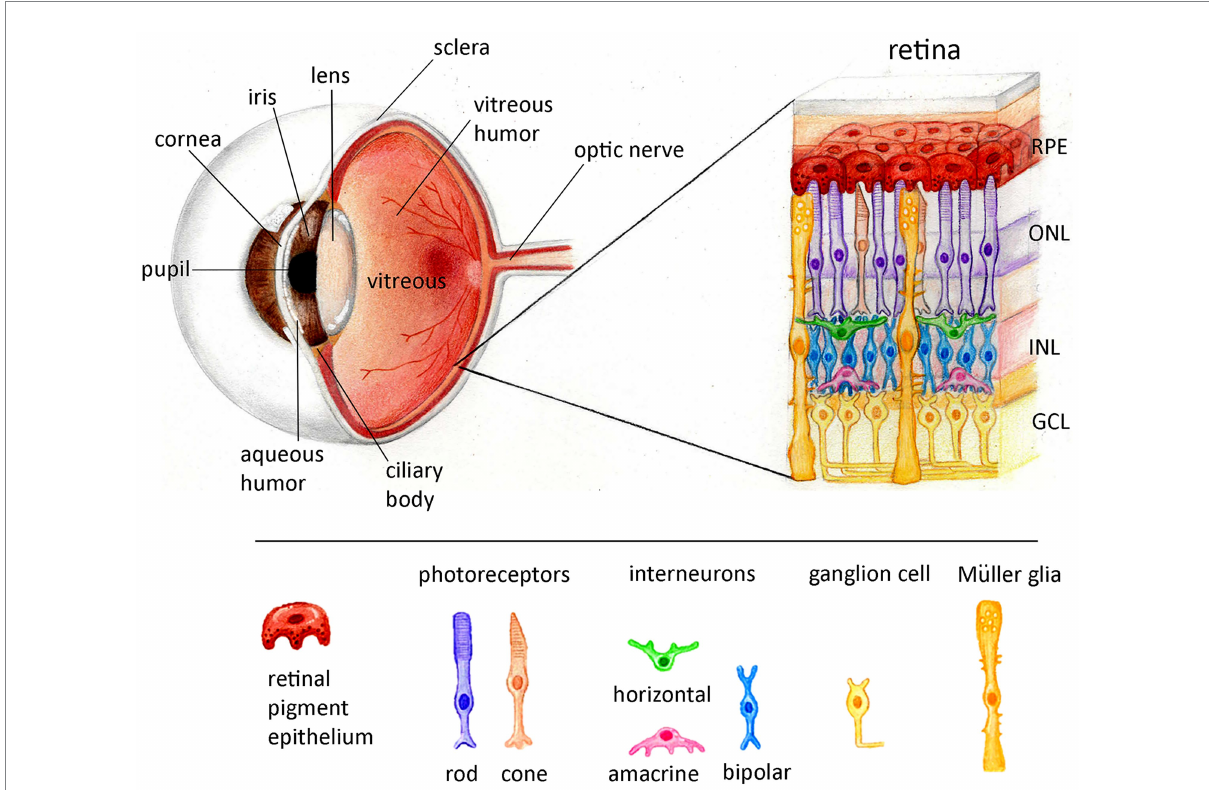
FIGURE 1 Schematic representation of the anatomical features of the eye and the lamination of the retina. The eye is anatomically divided in three layers. The external layer of the eye consists of the cornea, and sclera. The intermediate layer includes-at the anterior-the iris and ciliary body and in the posterior the choroid (not shown here). The internal layer is comprised by the retina. The space is filled with fluid called the aqueous humor, at the anterior chamber, or vitreous humor between the lens and the retina. The retina is divided in two compartments: one non-neuronal, the retina pigment epithelium (RPE) and one neuronal, the neuroretina. The vertebrate neuroretina is laminated in three layers of nerve cell bodies and two layers of synapses. The outer nuclear layer (ONL) consists of the somata of the rods and cones, the inner nuclear layer (INL) consists of the cell bodies of the bipolar, horizontal and amacrine interneurons and the ganglion cell layer (GCL) contains cell bodies of ganglion cells and some displaced amacrine cells. The axons of the ganglion cells are forming the optic nerve interconnecting the retina with the